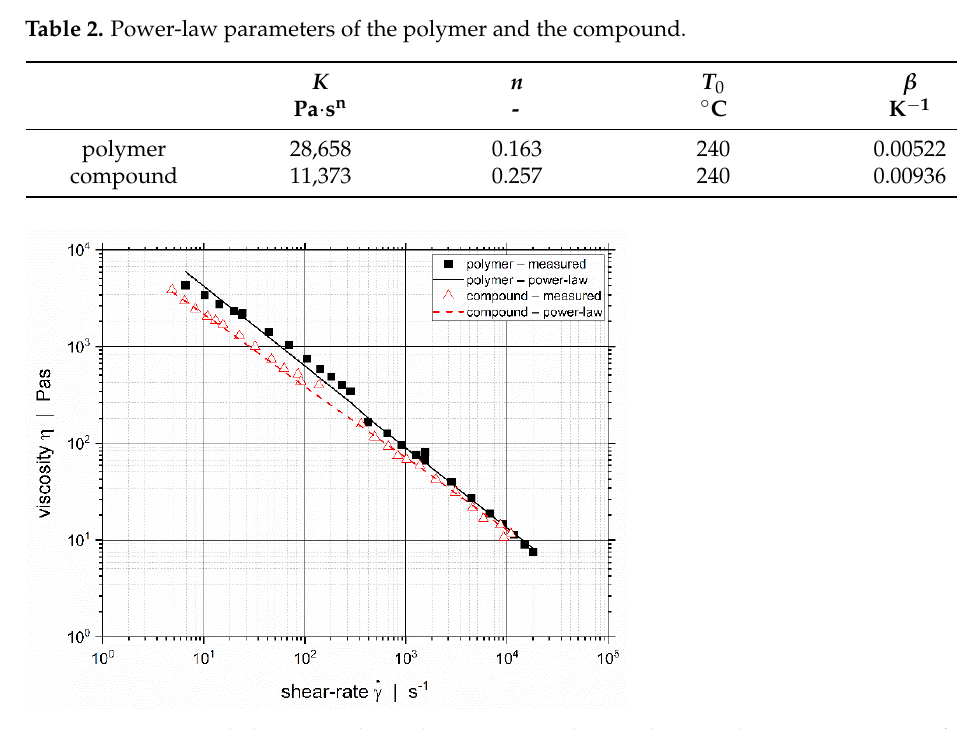
Figure 1. Measured shear-rate dependent viscosity data and power-law approximation for the temperature setting of 235 °C.